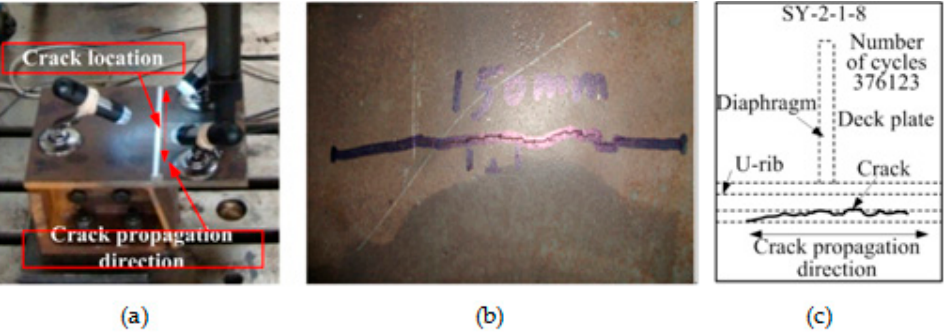
Figure 3. The crack of the specimen SY-2-1-8: ( a ) Fatigue test; ( b ) crack of the specimen; and ( c ) the position of the crack.